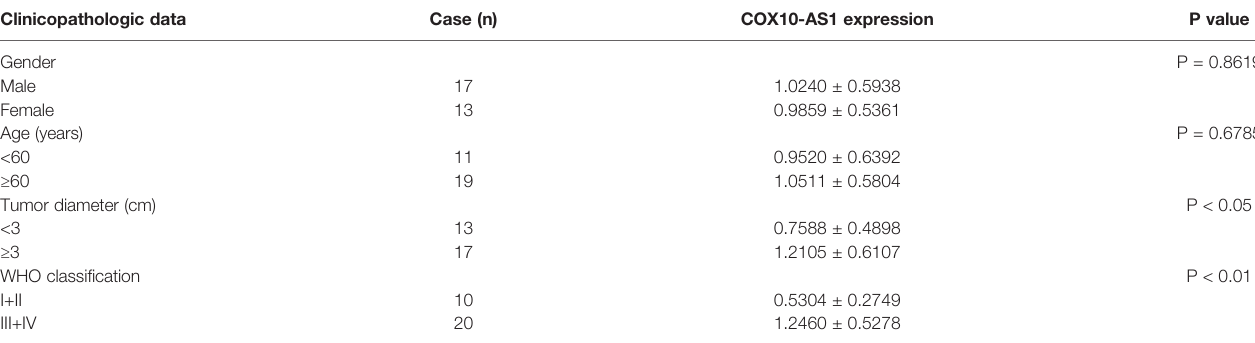
TABLE 1 | Correlation of clinicopathological characteristics between COX10-AS11 and glioma patients. Clinicopathologic